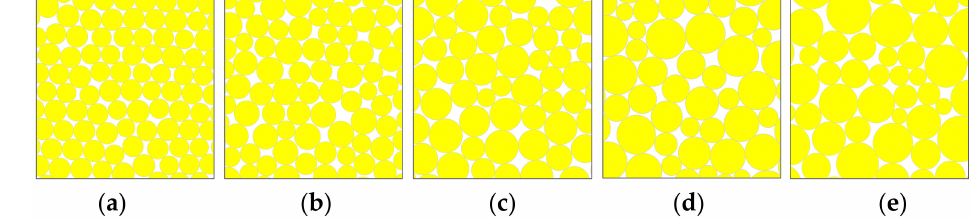
Figure 7. The local view of models with different grain size heterogeneity ( a ) R max /R min = 1.2; ( b ) R max /R min = 1.5; ( c ) R max /R min = 2.0; ( d ) R max /R min = 2.5; ( e ) R max /R min = 3.0.